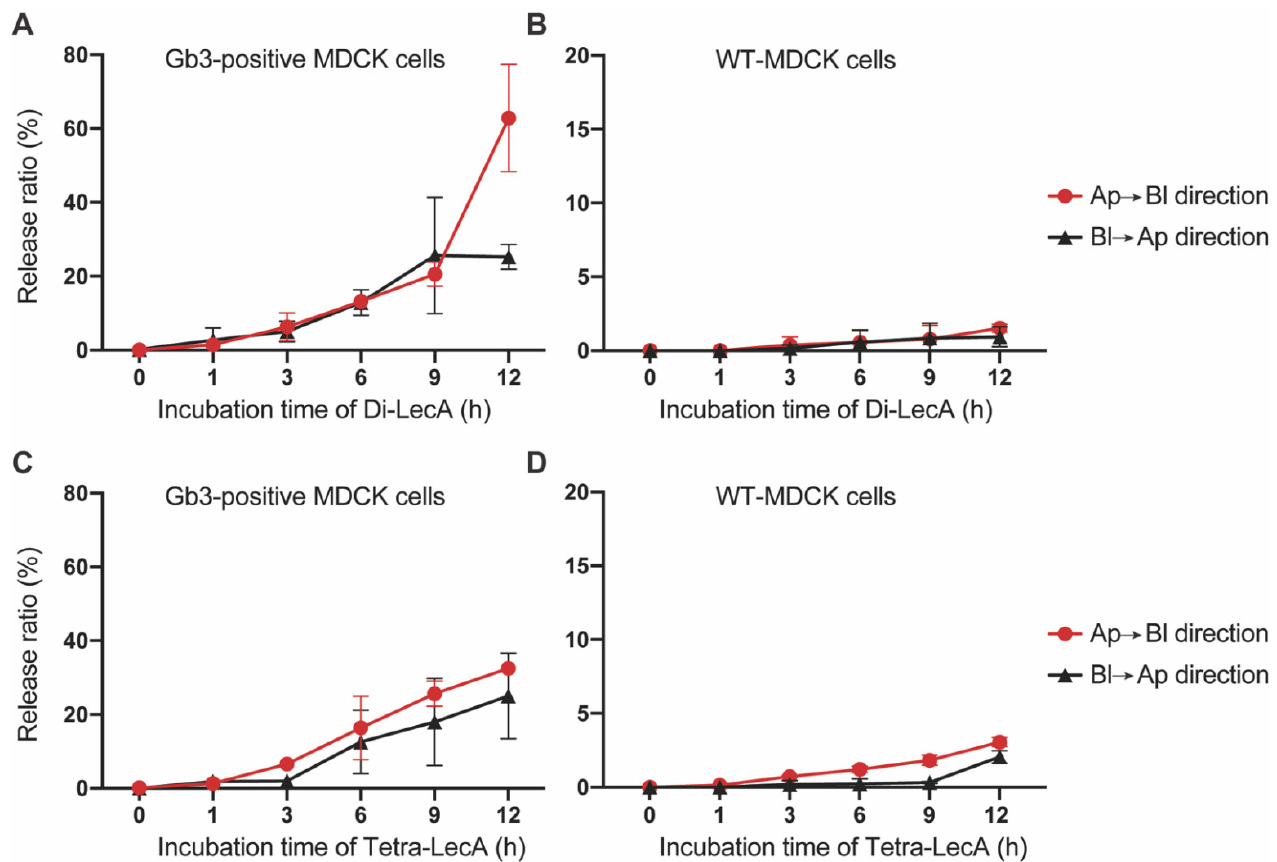
Figure 4. Release efficiencies of Di-LecA and Tetra-LecA. ( A ) The release efficiencies of Di-LecA were determined after crossing cellular monolayers that consist either of Gb3-positive MDCK cells ( A ) or Gb3-negative WT-MDCK cells ( B ). Fluorescently labeled Di-LecA was dropped in the top Transwell chamber or the bottom Transwell chamber. After the indicated incubation periods, fluorescent Di-LecA solution was collected from the chambers. The fluorescence intensity of the lectin solutions was measured via a microplate reader. The release efficiency was calculated according to the formula shown in Section 2.5. ( C ) The release efficiencies of Tetra-LecA were measured after crossing cellular monolayers consisting of either Gb3-positive MDCK cells ( C ) or Gb3-negative WT-MDCK cells ( D ). Monolayers that consist of WT-MDCK cells were used to confirm the specificity of lectin-triggered transcytosis. For each time point, the included sample number n was greater or equal to 3. Error bars represent the SD.